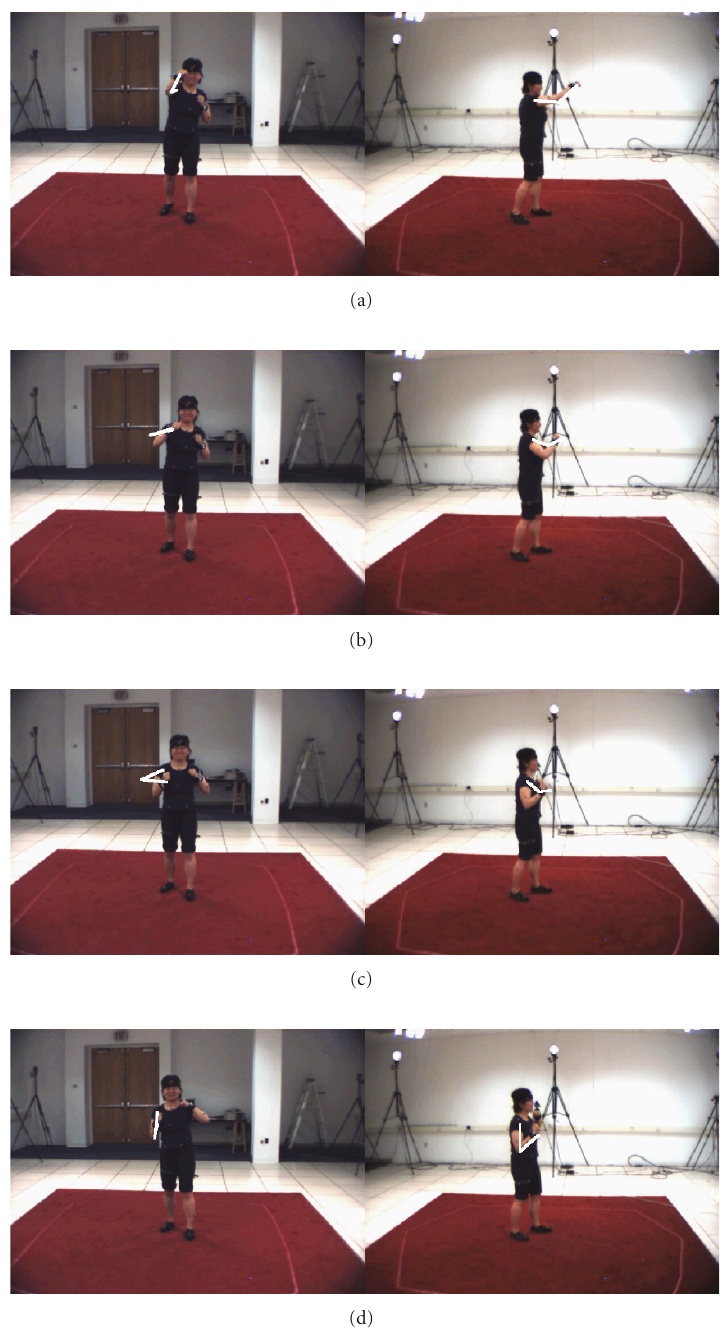
Figure 10: HumanEva box sequence for the subject 1, using Inverse